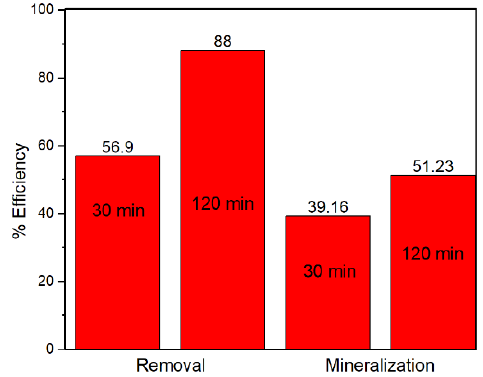
Figure 8. Total organic carbon (TOC) removal using FeZ-8.